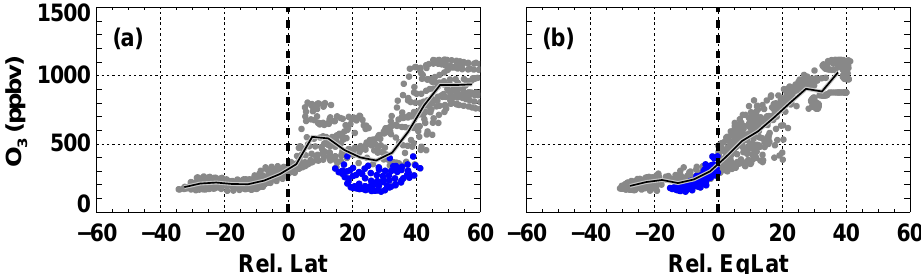
Fig. 11. Ozone at 380K and from 110 ◦ –150 ◦ W in longitude on 16 April 2008, (a) as a function of relative latitude to the 380K dynamical tropopause (6pvu in Fig. 10), and (b) as a function of relative EqLat to the dynamical tropopause. The blue points highlight the parcels that are on different sides of the tropopause when using relative latitude versus relative EqLat.